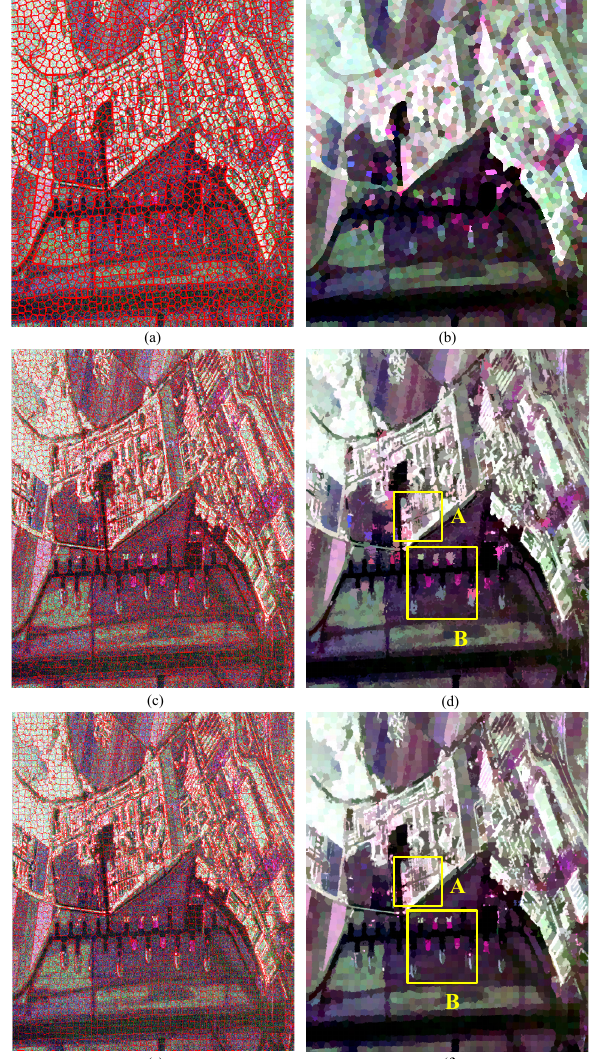
Fig. 3. Superpixel generation results of Liu’s, Qin’s, and our proposed approaches with K = 2200 for ESAR image. The first column denotes the final superpixel maps of different methods. The red lines superimposed onto the Pauli images depict the superpixel boundaries. The second column gives the representation maps, where the coherency matrix of each pixel is replaced by the average value of the superpixel this pixel belongs